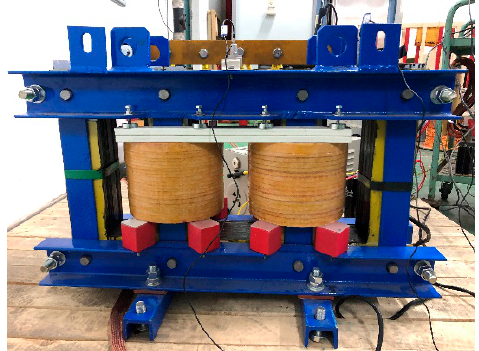
Figure 2. Reduced-scale autotransformer.